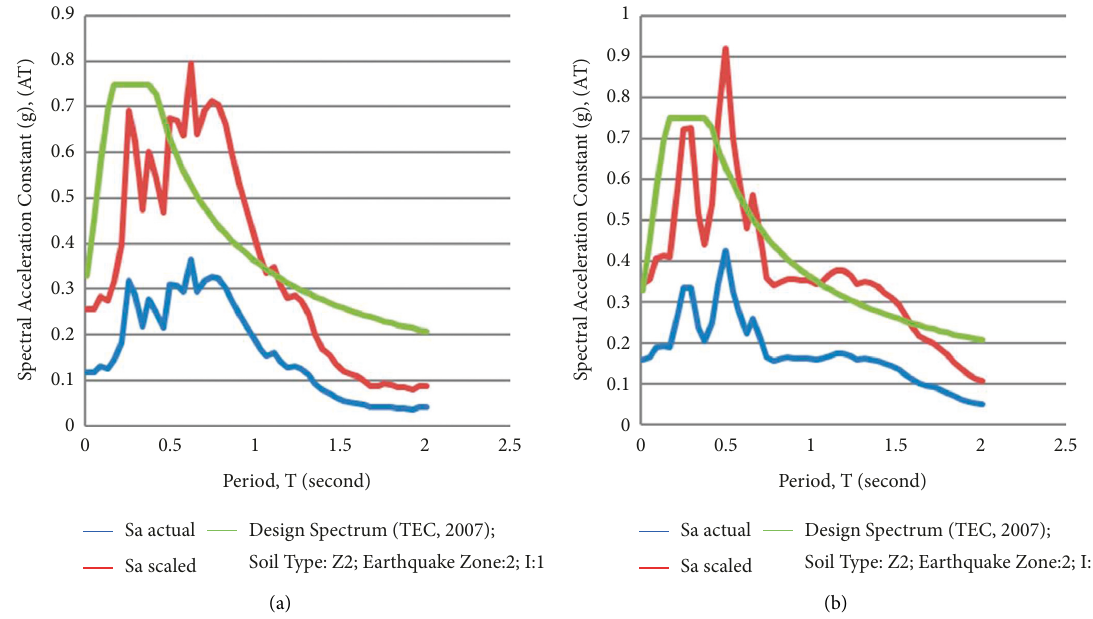
Figure 15: Evaluation of A(T) spectral acceleration constants at Bala station for (a) North-South (N-S) and (b) East-West (E-W) components of earthquake epicenter at Kayseri-Kocasinan ( M L :